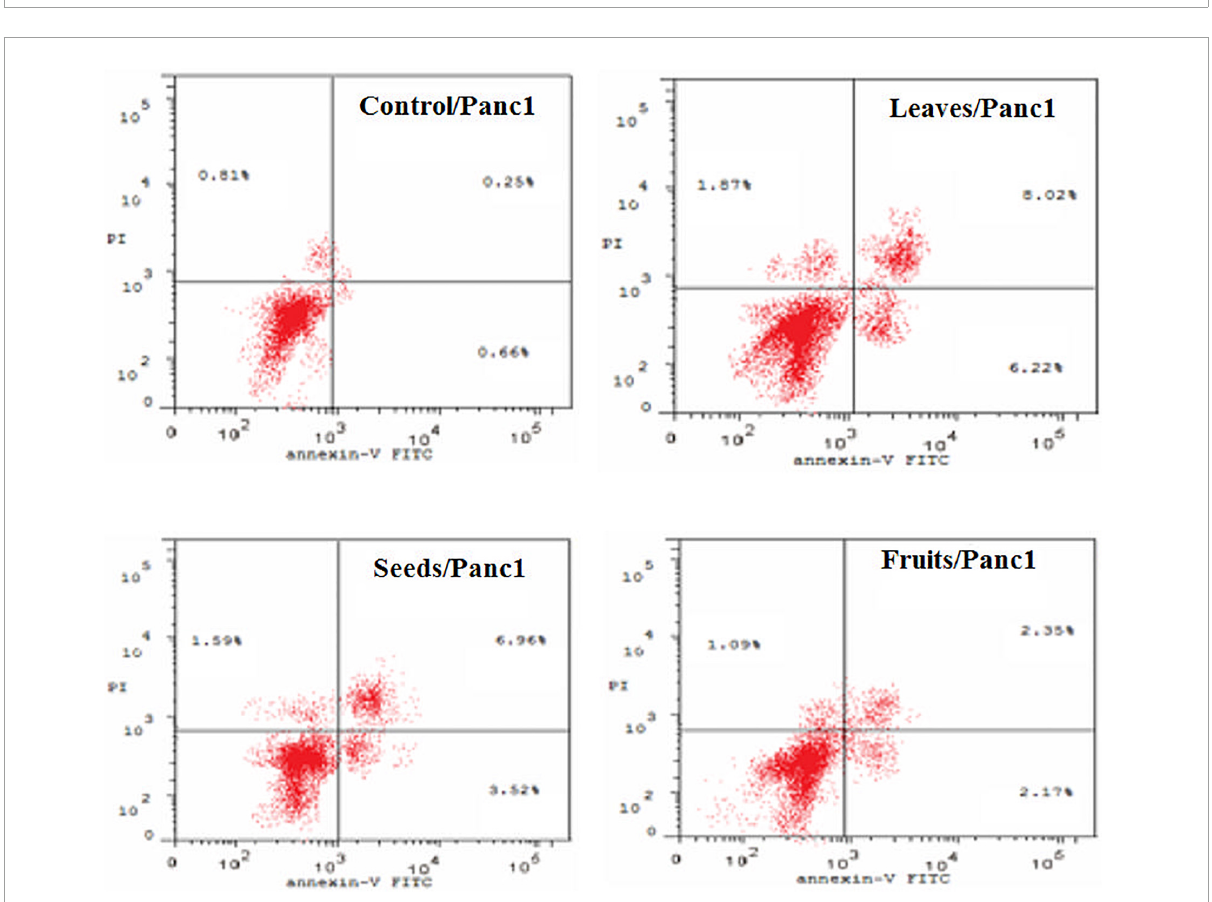
FIGURE9 Induction of apoptosis after treatment of panc1 cells with leaf, seed, and fruit extracts separately in comparison with